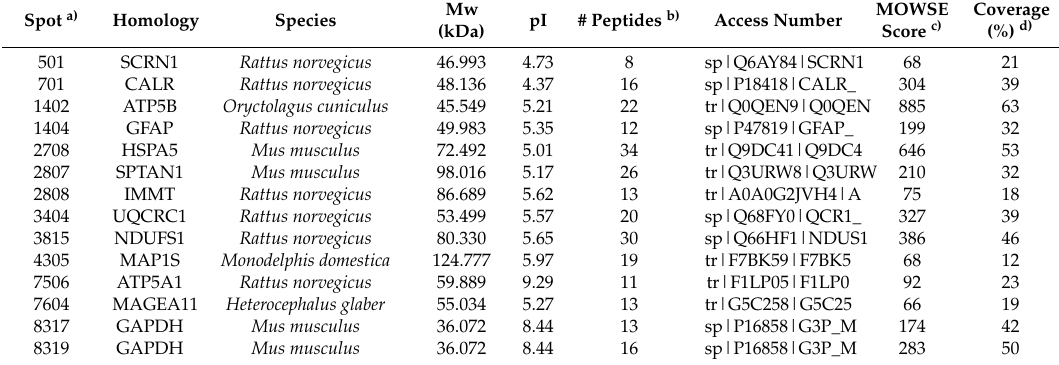
Table 1. Brain proteins identified by fingerprinting peptide and MS/MS analysis of peptides from 2-D exscinded spots using MASCOT software.